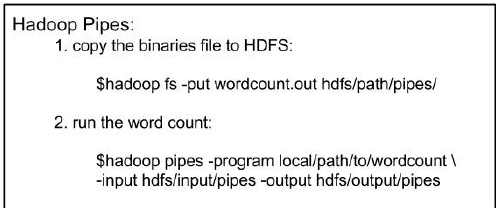
Fig. 9. Flow chart of GPU-Hadoop Pipes The command line interface of Hadoop Pipes is shown in Fig. 10. Both Map and Reduce functions are assembled into one C/C++ program.